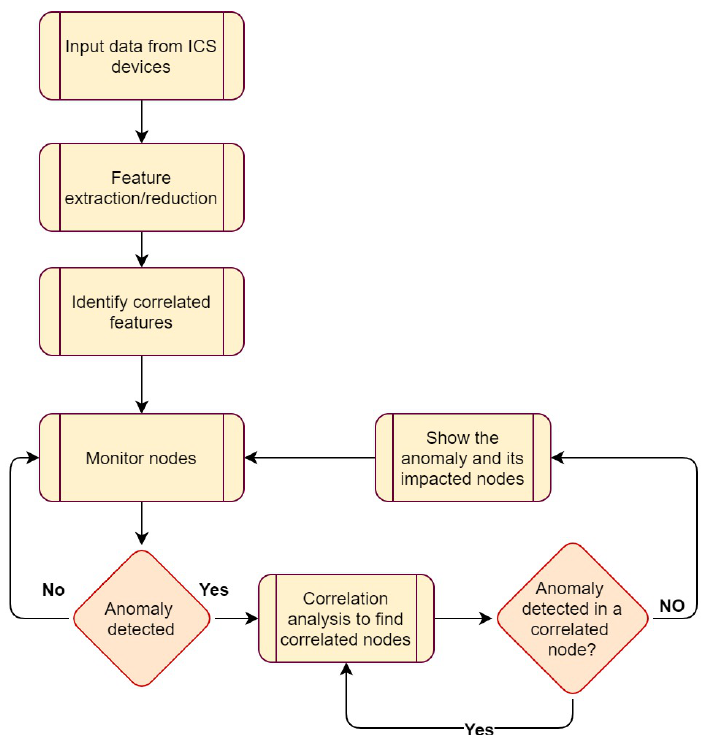
Figure 1. The proposed anomaly detection for ICS networks.